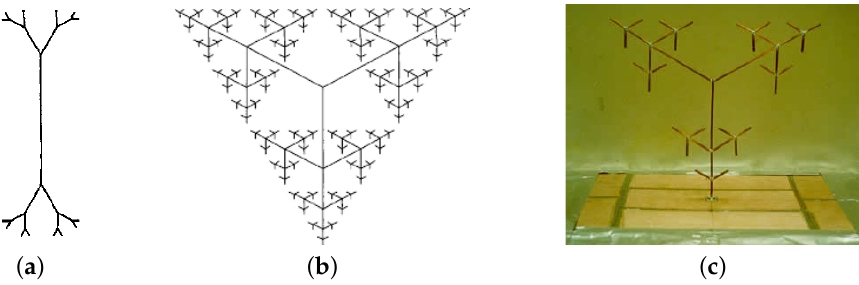
Figure 23. Fractal Tree Antennas: ( a ) Fractal tree, ( b ) A Stage 4 ternary fractal tree (Image source: Werner and Ganguly [15]), and ( c ) A prototype Tri-band fractal ternary tree monopole antenna used in miniaturized dipole antennas (Image source: http://cearl.ee.psu.edu/projects/project2-1-1.html, accessed on 22 June 2022).